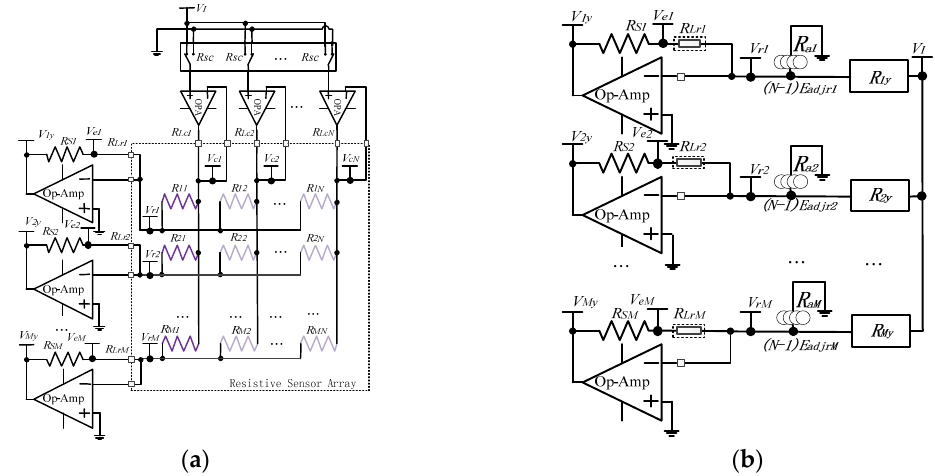
Figure 2. ( a ) Full two ‐ wire readout circuit; ( b ) Equivalent circuit model of the full two ‐ wire readout circuit (Model C).